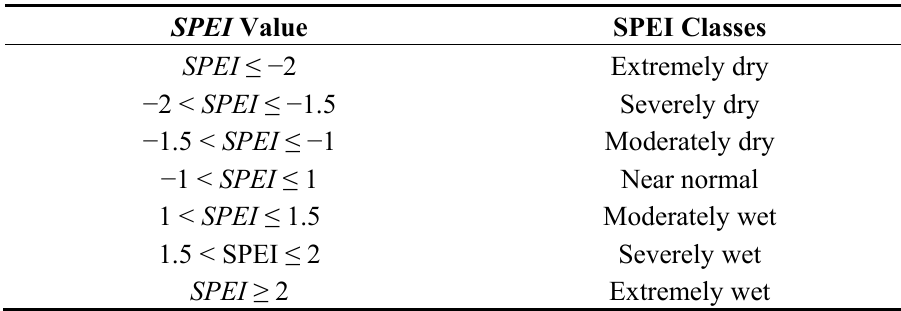
Table 1. Classes of dryness/wetness grade according to the Standardized Precipitation Evapotranspiration ( SPEI)